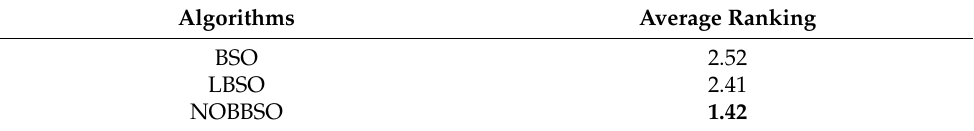
Table 6. Statistical